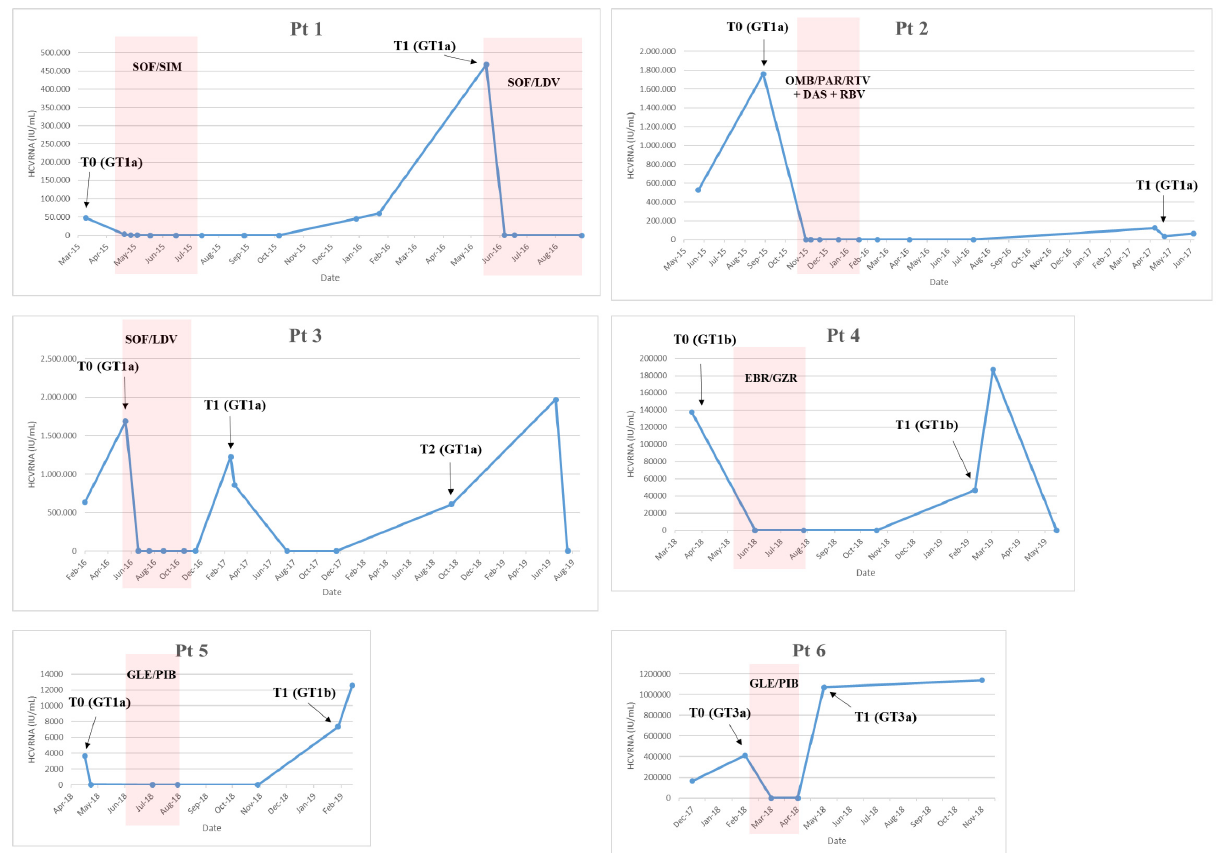
Figure 1. Patient HCV RNA viral load over time. The sampling times T0, T1, and T2 are indicated. The period and type of treatment are indicated in the red box. DAS: Dasabuvir; EBR: Elbasvir; GLE: Glecaprevir; GZR: Grazoprevir; OMB: Ombitasvir; PAR: Paritaprevir; PIB: Pibrentasvir; RBV Ribavirina; RTV: Ritonavir; SIM: Simeprevir; SOF: Sofosbuvir.